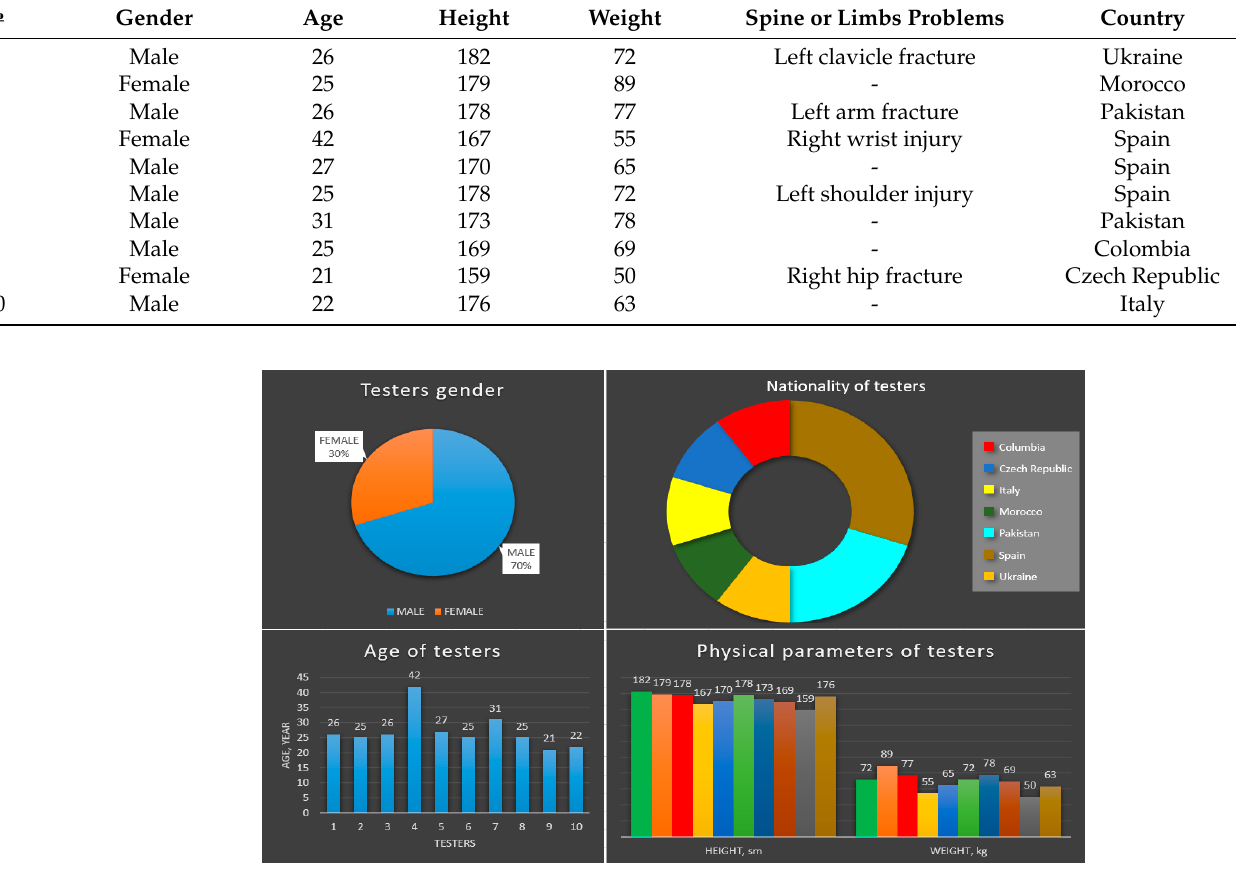
Figure 1. Main information about test participants.